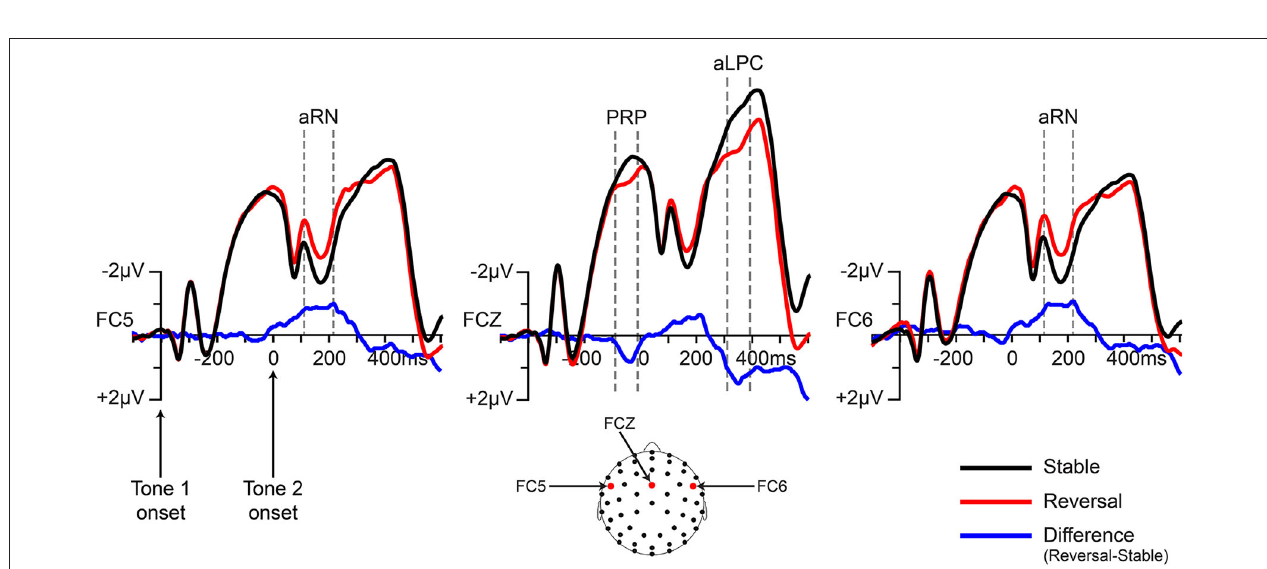
FIGURE 3 | Behavioral data showing the number of stable trials preceding a reversal trial as a function of the overall frequency of reversal trials (A), and the cumulative probability of a reversal occurring